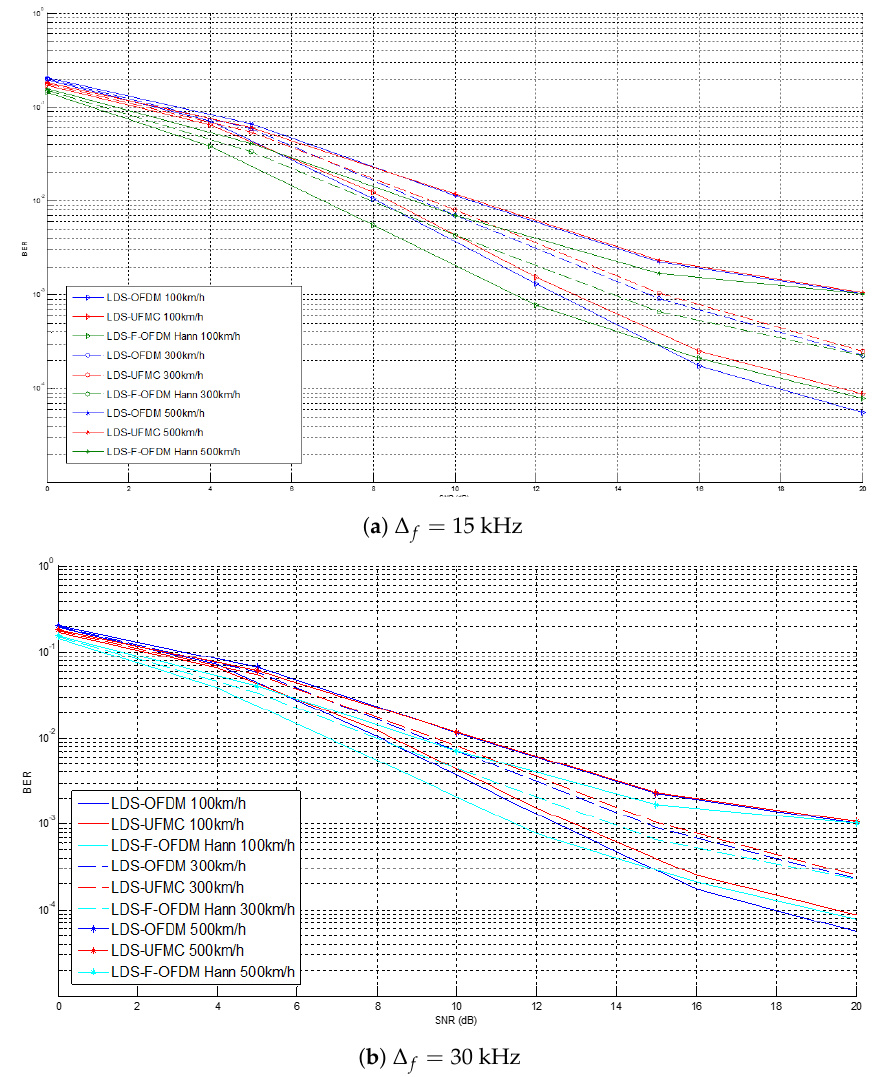
Figure 7. Schemes comparison over the EVA channel with different speed